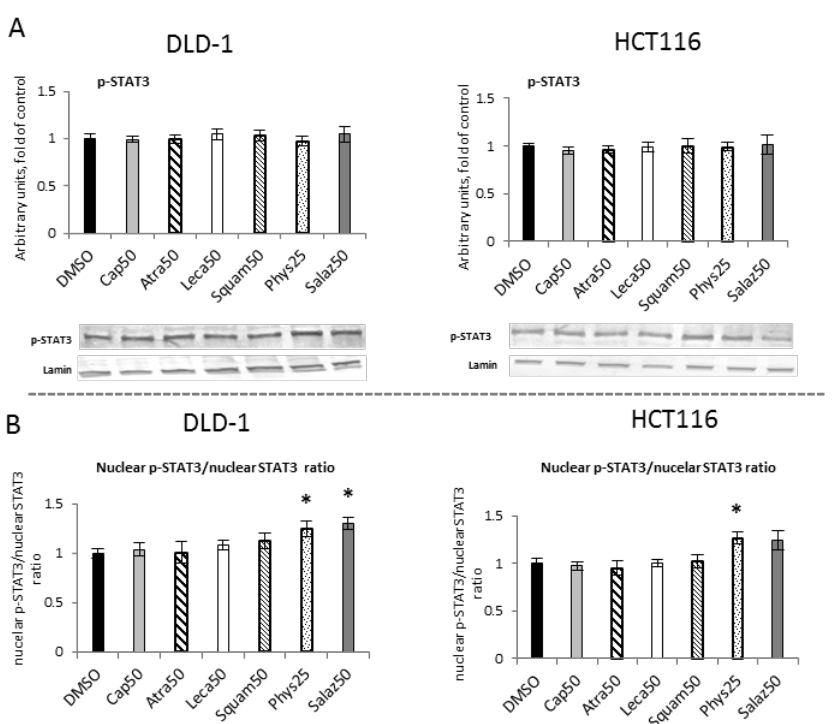
Figure 10. The effect of lichen-derived compounds on the level of p- STAT3 in DLD -1 and HCT116 cells. ( A ) The level of p-STAT3 protein in the nuclear fraction. Representative Western immunoblots are presented under the graphs. Results (means ± SEM from three separate experiments) are presented as a fold change to control after normalization against the level of lamin. ( B ) The ratio of nuclear p-STAT3 and nuclear STAT3 compared with the control group. DMSO , vehicle control; Cap50 , caperatic acid (50 µ M); Atra50 , atranorin (50 µ M); Leca50 , lecanoric acid (50 µ M); Squam50 , squamatic acid (50 µ M); Phys25 , physodic acid (25 µ M); Salaz50 , salazinic acid (50 µ M).